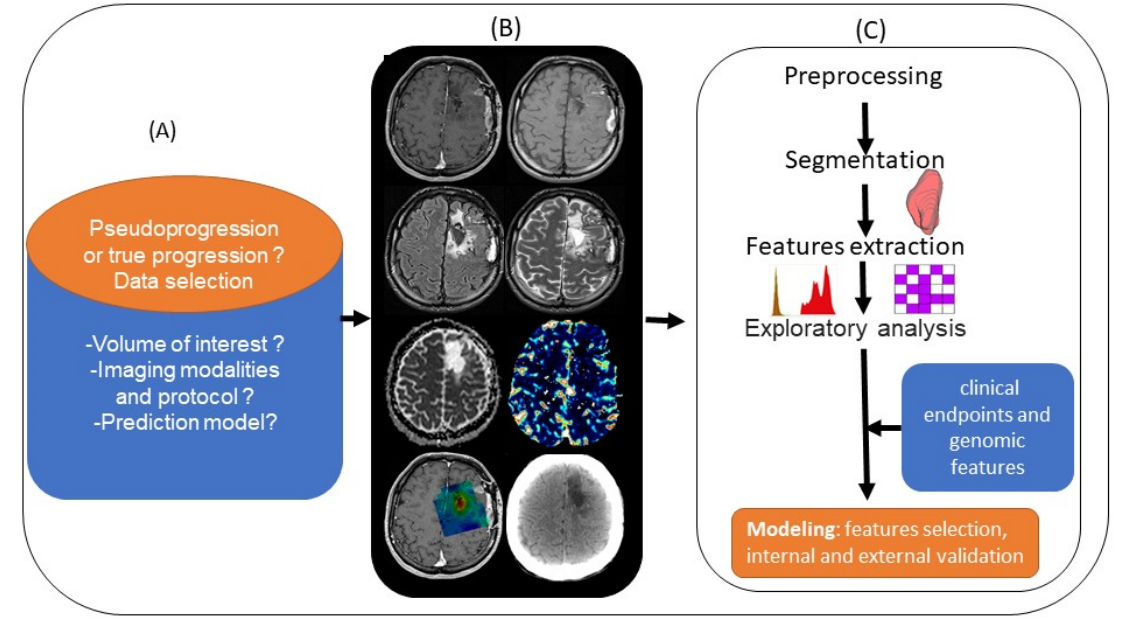
Figure 4. Standard pipeline of radiomics analysis applied to the differentiation of PsP from TP: ( A ) planning the radiomics study by asking basic questions. ( B ) Integrating multimodal images (left to right and top to bottom: T1 pre- and post-contrast enhancement, T2, FLAIR, ADC and rCBV map, metabolic MRSI map, and CT scan). ( C ) Preprocessing and segmentation of volume of interest in MRI images, with extraction of features from within the defined volume of interest quantifying tumor intensity, shape, and texture. After features selection, the radiomics features are combined with clinical and genomics data. A model is established after internal and external validation.